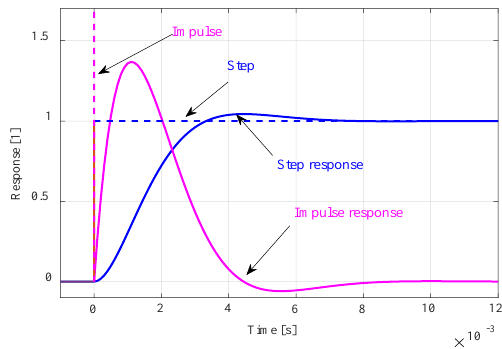
Figure 1. Response maps of the pulses and steps.